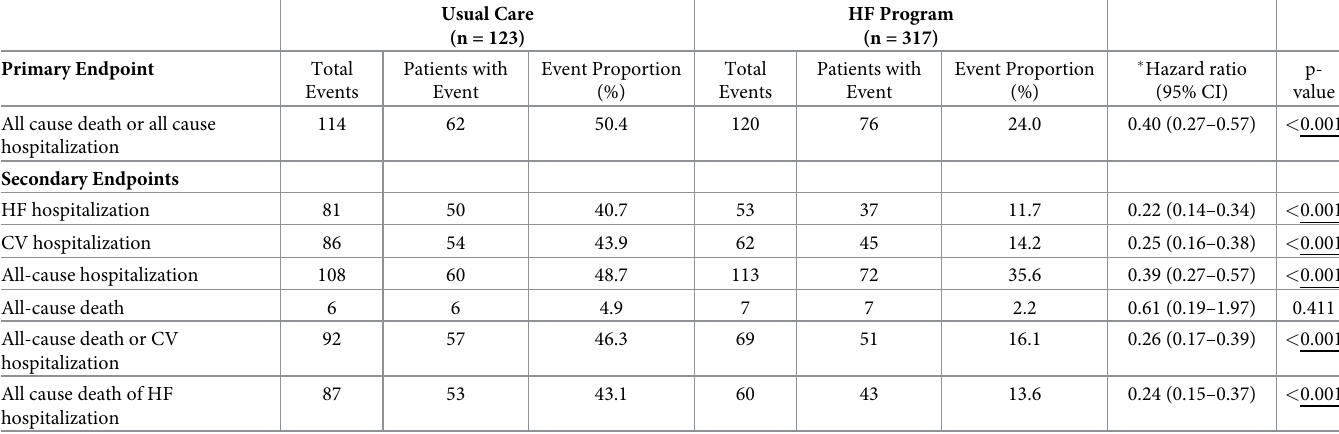
Table 3. Multivariable adjusted Cox regression analyses evaluating the outcome of HF program management vs. usual care on clinical